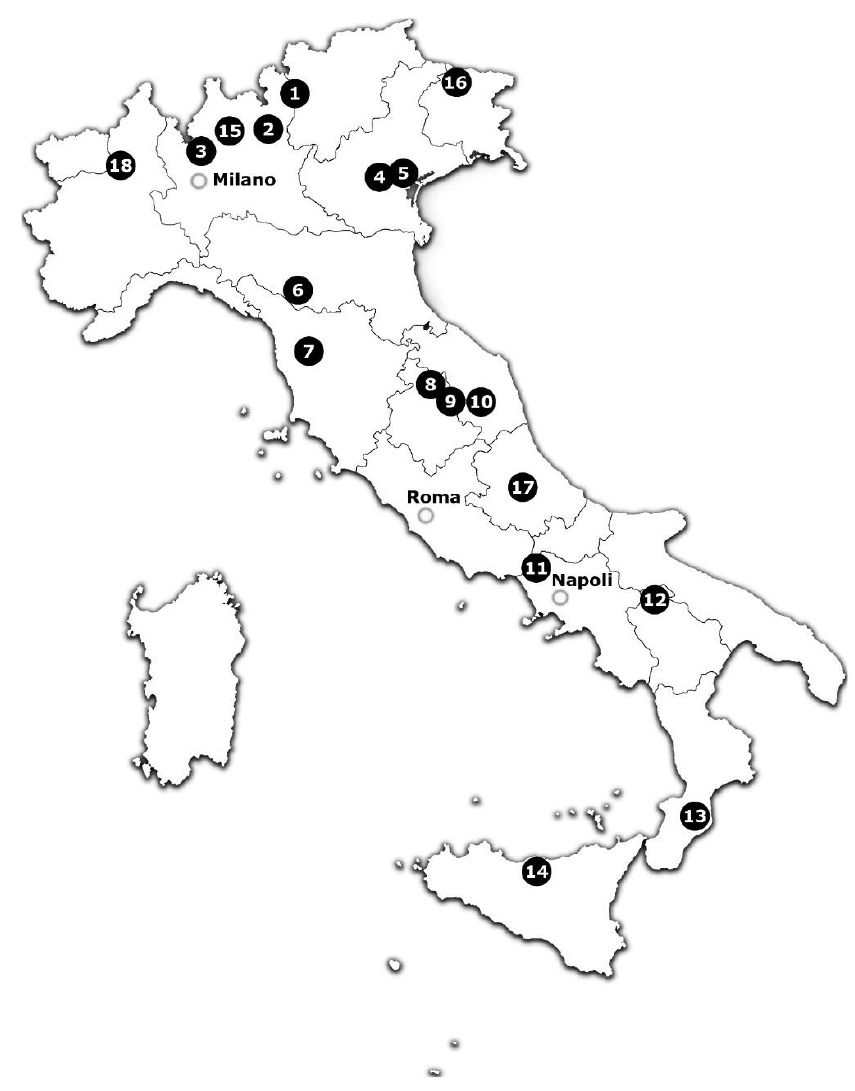
Figure 1. Map of Italy with the different sampling points. The black labels indicate the locations where samples were collected. The number inside the label indicates the number of different brand samples collected in each place.